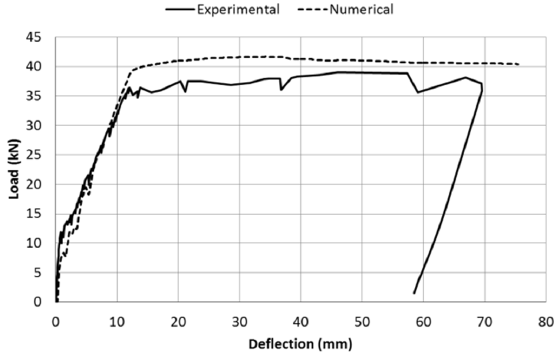
Figure 7. Beam CB: Experimental/Numerical load-midspan deflection curve.